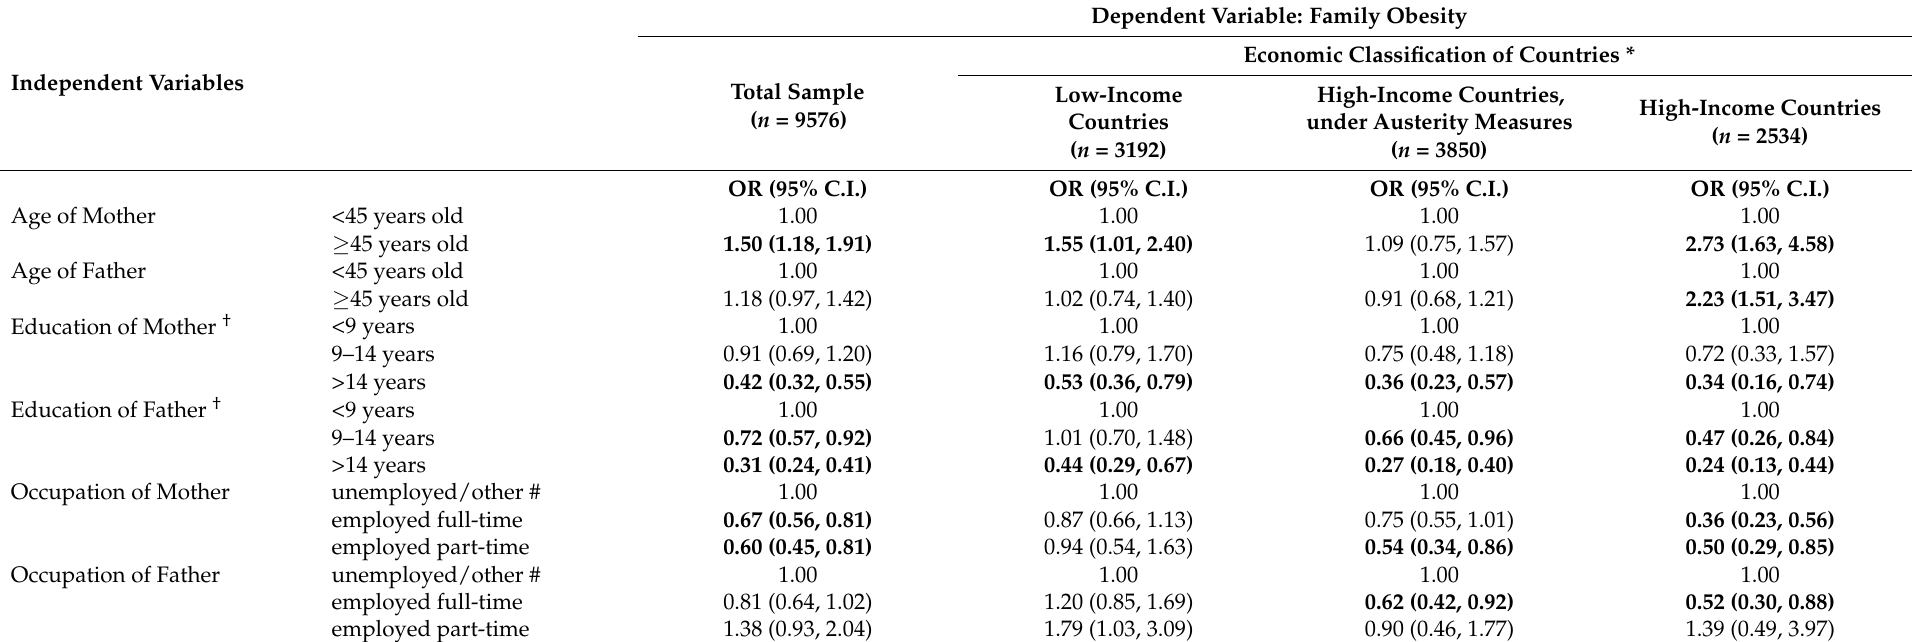
Table 3. Univariate logistic regression analyses examining the associations between sociodemographic characteristics and family obesity for the total sample and by country’s economic